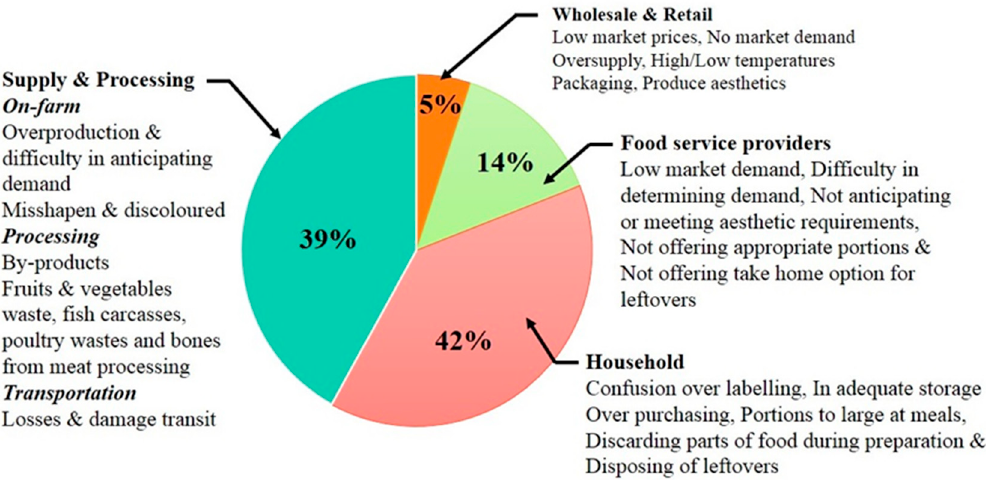
Figure 1. A summary of major sources of food waste from producer to household consumer [12–14].